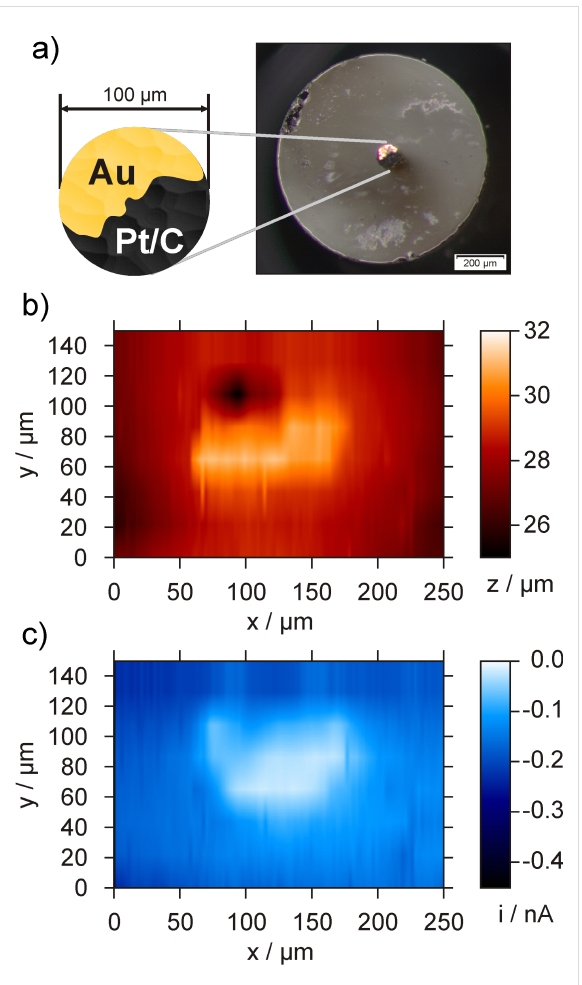
Figure 3: 4D SF/CD-SECM experiment at a partly filled microcavity. a) Optical micrograph with a scheme of the catalyst filling, b) topo- graphy and c) current image at the point of closest approach. E sample = − 300 mV, E tip = − 600 mV, d tip = 1.6 µm, f osc = 299.4 kHz, stop crite- rion: